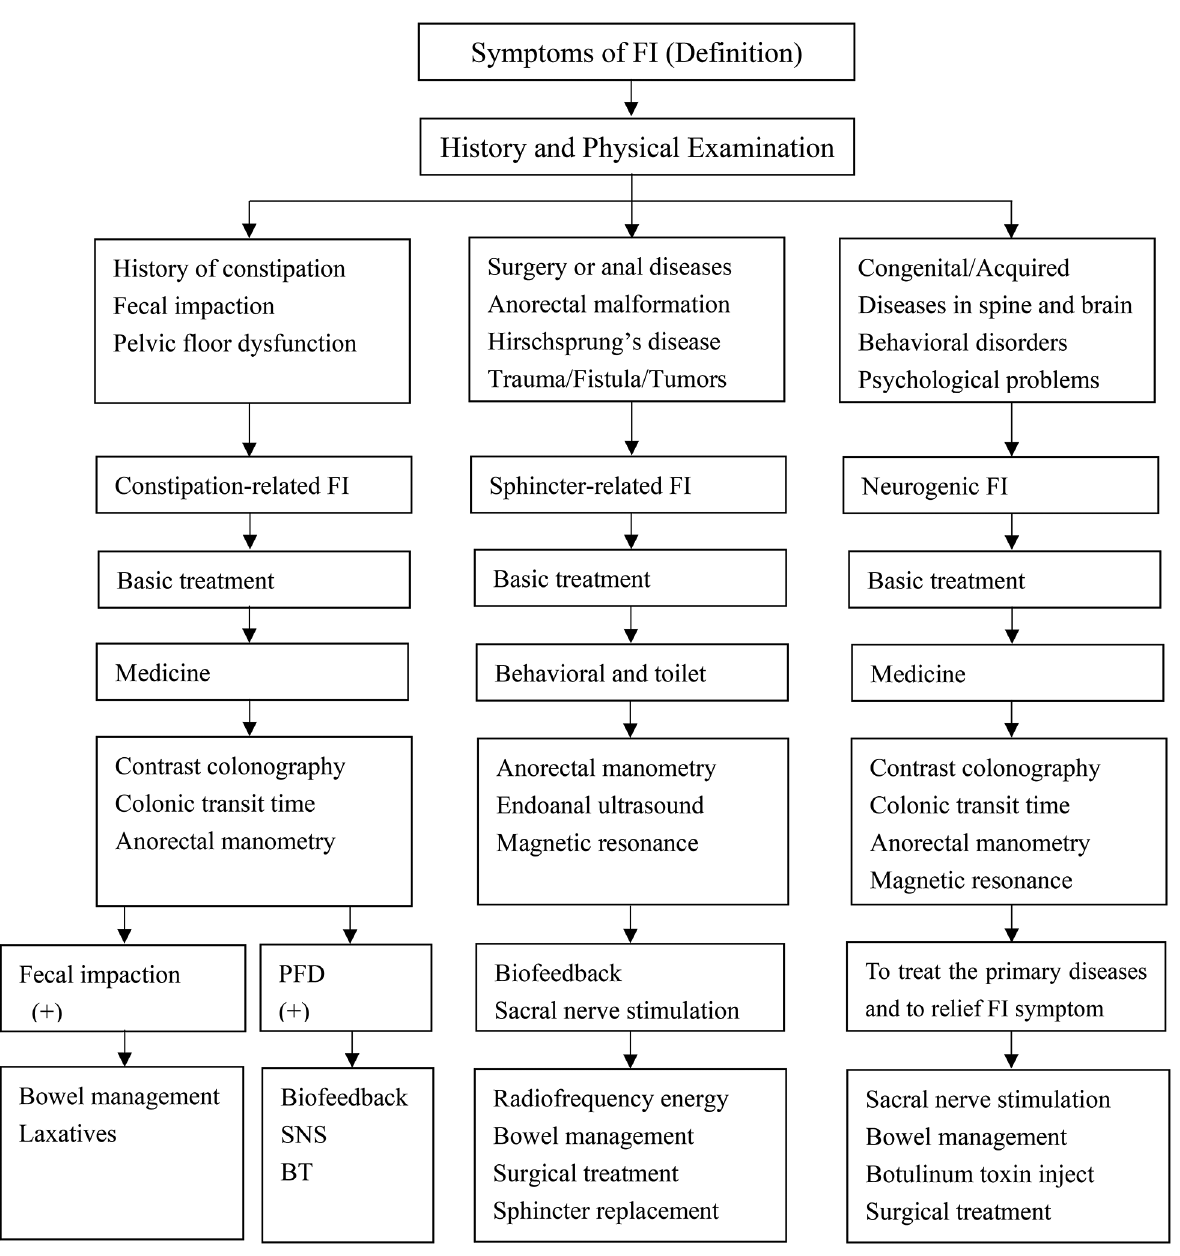
TABLE 1 The potential diagnosis and management process of FI in children and